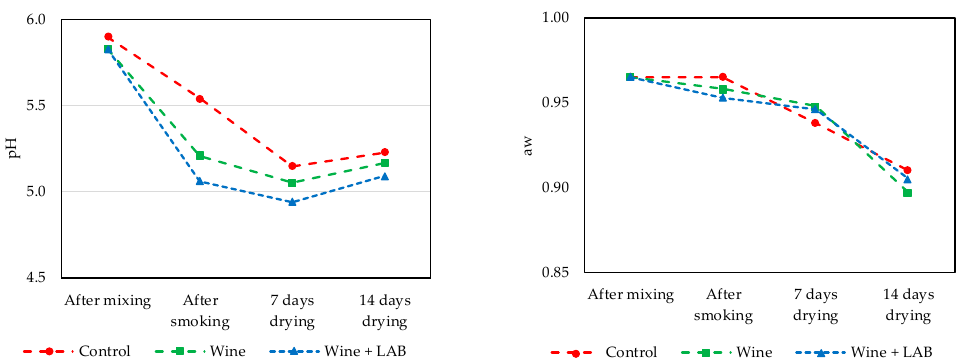
Figure 7. pH values ( left ) and water activity ( right ) measured in chouriço during processing ( n = 3).